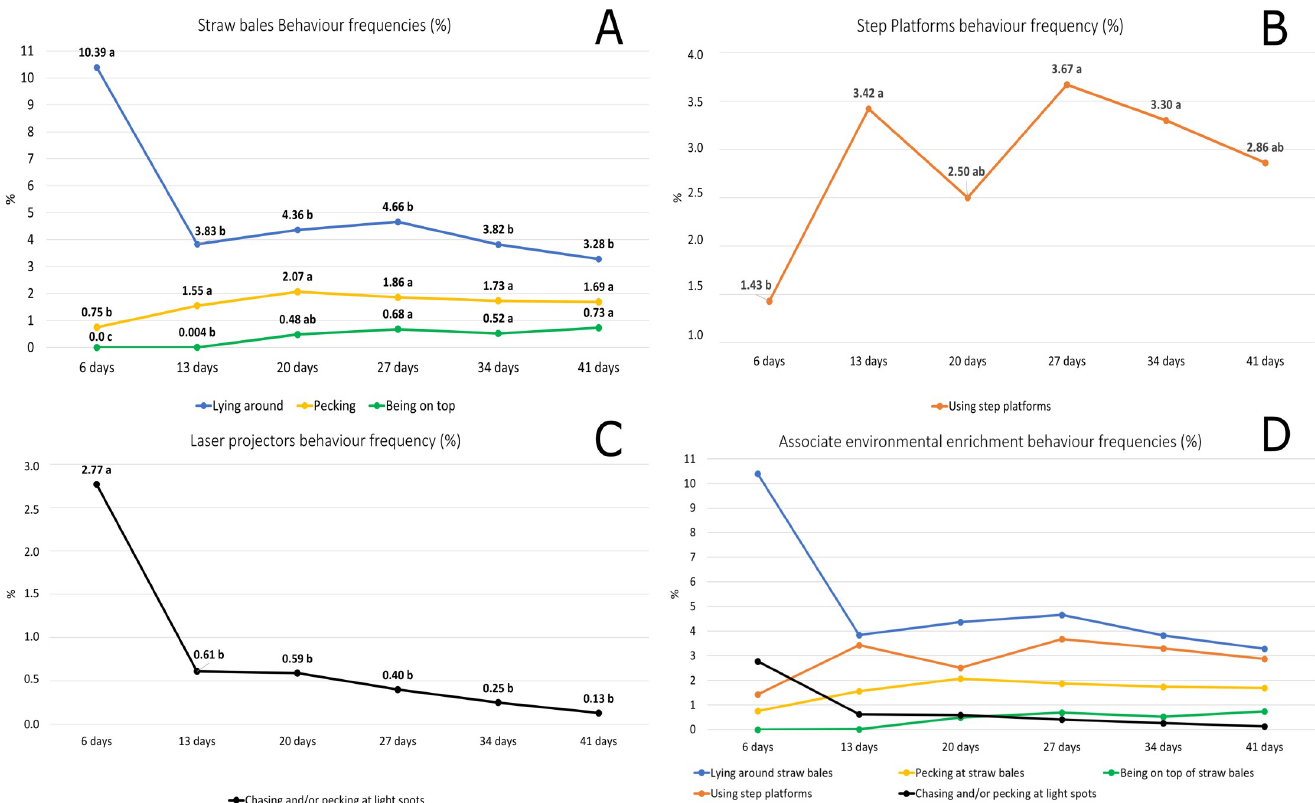
Fig 4. Frequencies (%) of behaviours associated with the provided environmental enrichment only. (A): Straw bales behaviour frequencies–Lying around ( F 5,14 = 17.15, P < 0.0001), Pecking ( F 5,14 = 9.76, P = 0.0004), and Being on top ( F 5,14 = 11.24, P = 0.0002). (B): Step platforms behaviour frequency–Using step platforms ( F 5,28 = 12.03, P < 0.0001). (C): Laser projectors behaviour frequency—Chasing and/or pecking at light spots ( F 5,14 = 13.51, P < 0.0001). (D): Associate environmental enrichment behaviour frequencies.